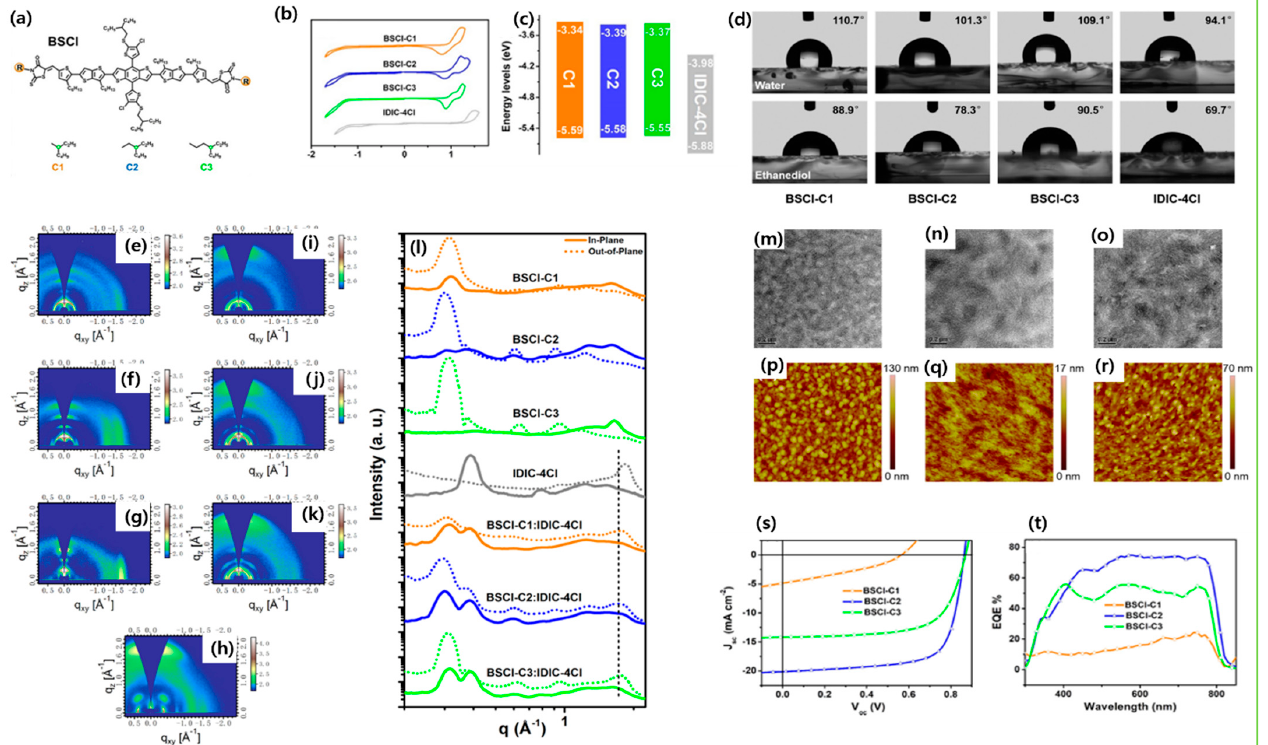
Figure 15. ( a ) Chemical structure of small-molecular donors. ( b ) Cyclic voltammograms (CV). ( c ) Energy level of the related donor and acceptor materials used in the SM-OSCs. ( d ) Contact angles of water and ethanediol droplets on BSCl-C1, BSCl-C2, and BSCl-C3 and IDIC-4Cl pristine films. ( e – h ) Two-dimensional GIWAXS patterns of donors BSCl-C1, BSCl-C2, and BSCl-C3 and acceptor IDIC-4Cl pure films. ( i – k ) Two-dimensional GIWAXS patterns of blended films under optimized conditions and ( l ) one-dimensional GIWAXS curves of BSCl-C1, BSCl-C2, BSCl-C3, and IDIC-4Cl pure and blended films under optimized conditions. ( m – o ) TEM images of blended films based on different donors BSCl-C1, BSCl-C2, and BSCl-C3 and ( p – r ) corresponding AFM height images. ( s ) Optimized J-V curves for the three systems and ( t ) EQE spectra of the corresponding devices. Adapted with permission from [123]. Copyright 2020, American Chemical